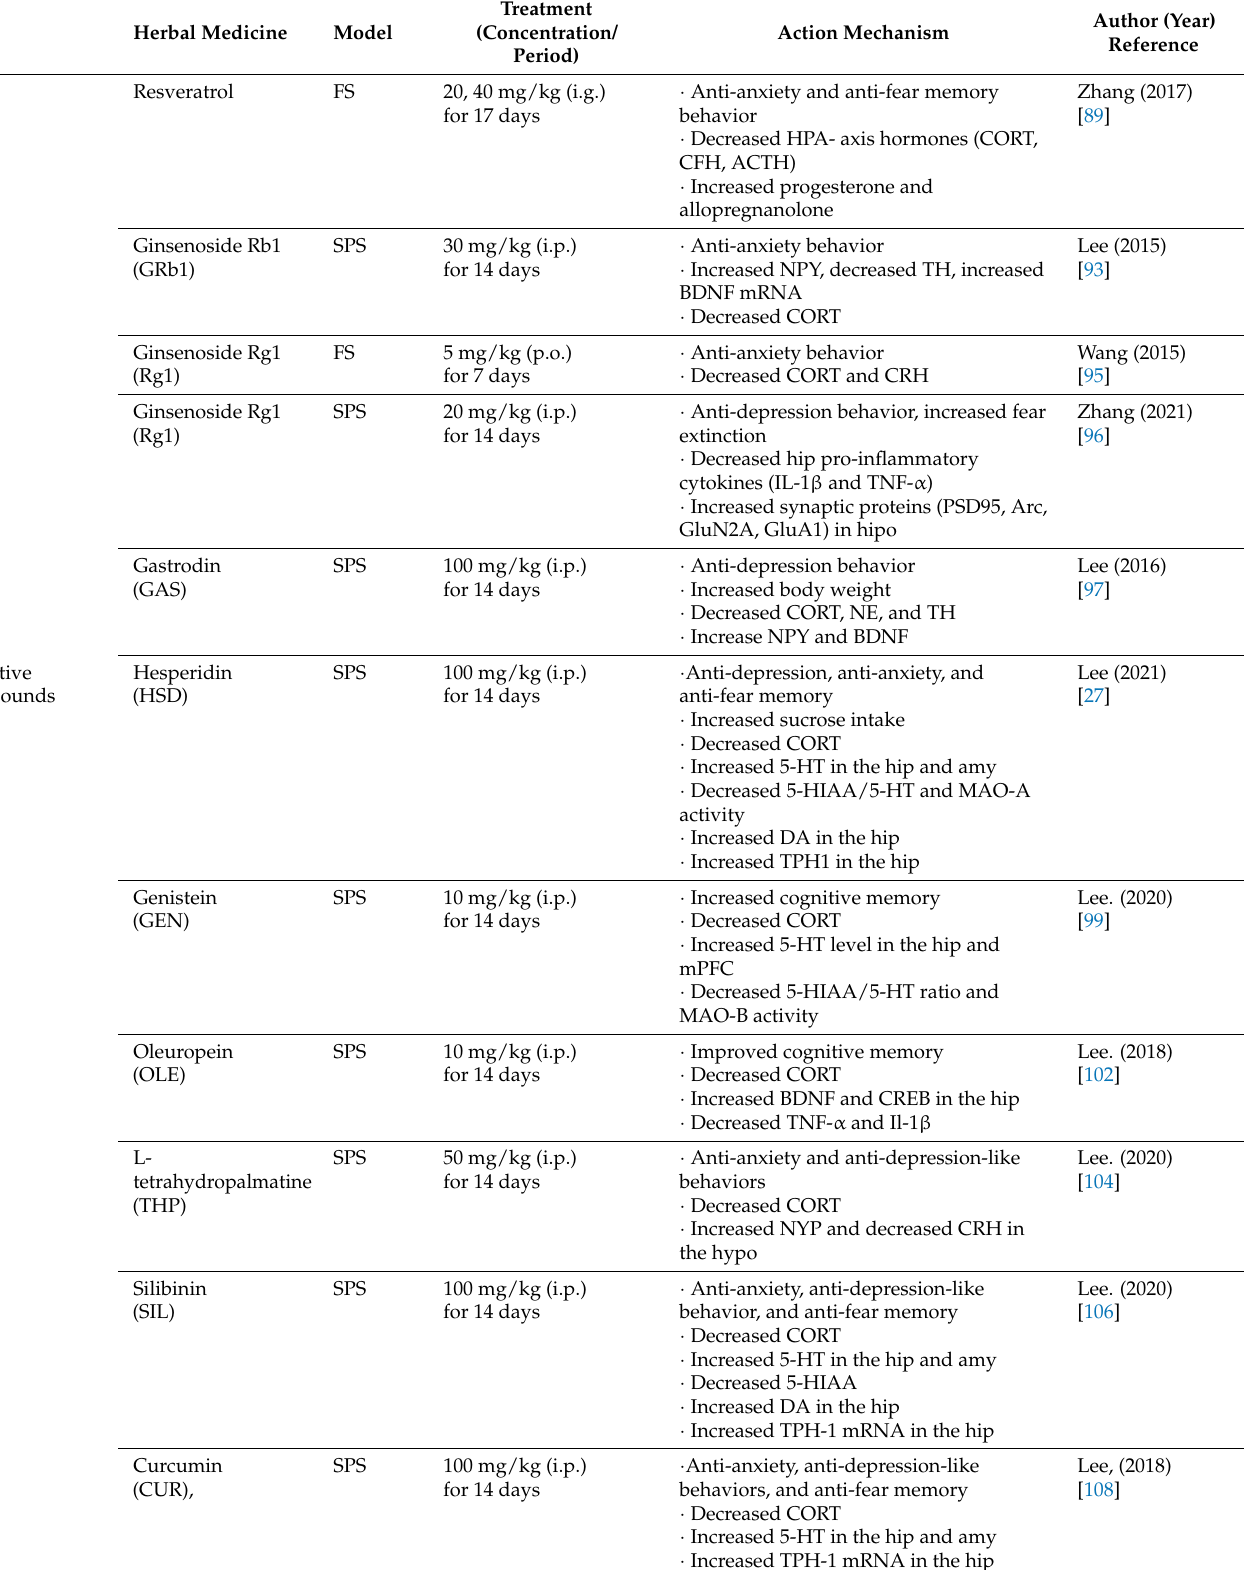
Table 1. Summary of the effects of herbal medicine used in PTSD animal model based on HPA